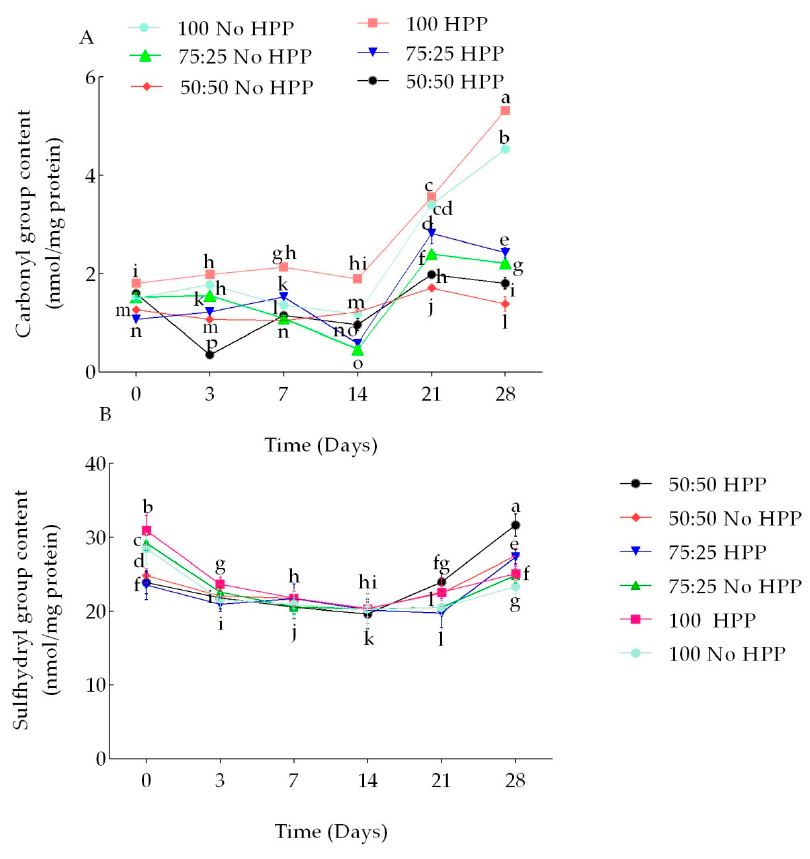
Figure 4. Effect of partial substitution of NaCl coupled with HPP on ( A ) carbonyl content and ( B ) sulfhydryl content of beef sausage under different cold storage days. Different lower case letters indicate significant differences at p < 0.05 in Duncan’s multiple range tests using two-way ANO- VA.